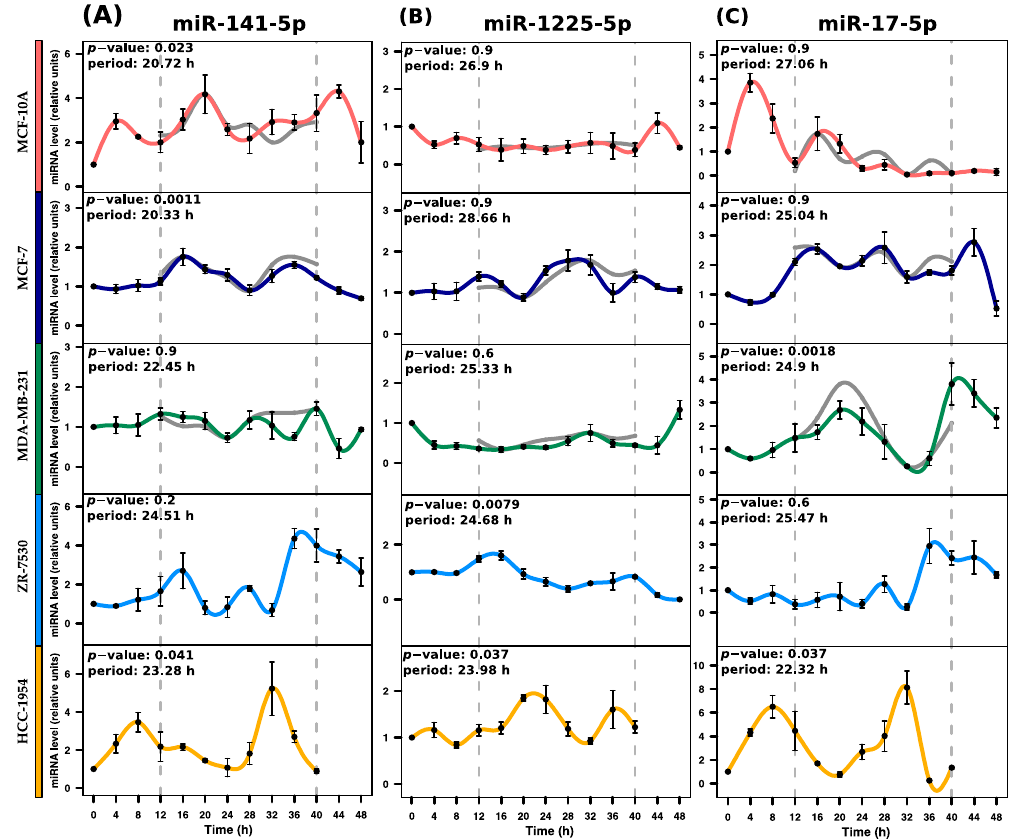
Figure 3. Expression profiles of miR-141-5p, miR-1225-5p, and miR-17-5p across breast cell lines as determined by RT-qPCR. Their rhythmic expression was evaluated by RT-qPCR in serum-shocked MCF-10A, MCF-7, MDA-MB-231, ZR-7530, and HCC-1954 cells over 48 h (4 h intervals). ( A ) miR-141-5p exhibits rhythmic profiles in MCF-10A, MCF-7 and HCC-1954 cells; ( B ) miR-1225-5p exhibits rhythmic profiles in ZR-7530 and HCC-1954 cells; ( C ) miR-17-5p exhibits rhythmic profiles in MDA-MB-231 and HCC-1954 cells. Data points (means of three biological replicates ± standard error of the mean (SEM)) were normalized using miR-106a-5p relative to the first time point ( t = 0). The p- value and period values of rhythmic profiles were obtained from the MetaCycle analysis and are illustrated at the top of each plot. Expression profiles with p- values less than 0.05 were considered rhythmic. For comparison purposes, the gray lines in the graphs concerning MCF-10A, MCF-7, and MDA-MB-231 illustrate the expression profiles obtained from the microarray data, which were scaled to the expression profile obtained from RT-qPCR assays. Dashed gray lines at 12 h and 40 h were added to show the period in which profiles were measured by microarray.